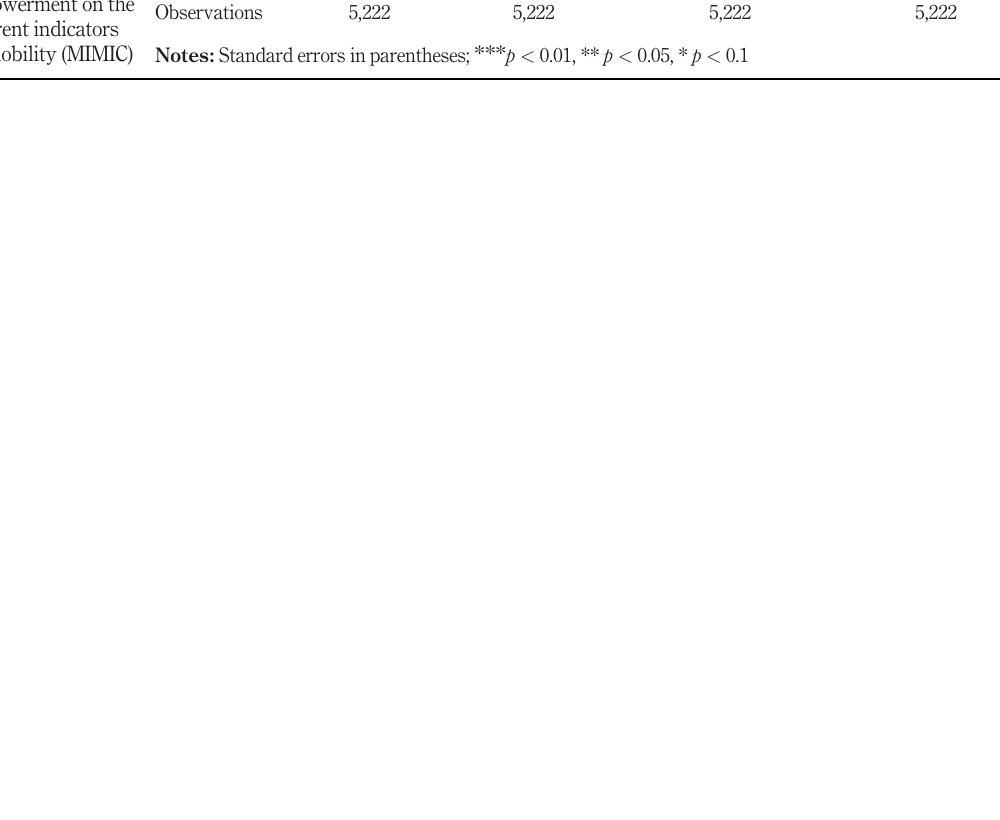
MI1 MI2 MI3 MI4